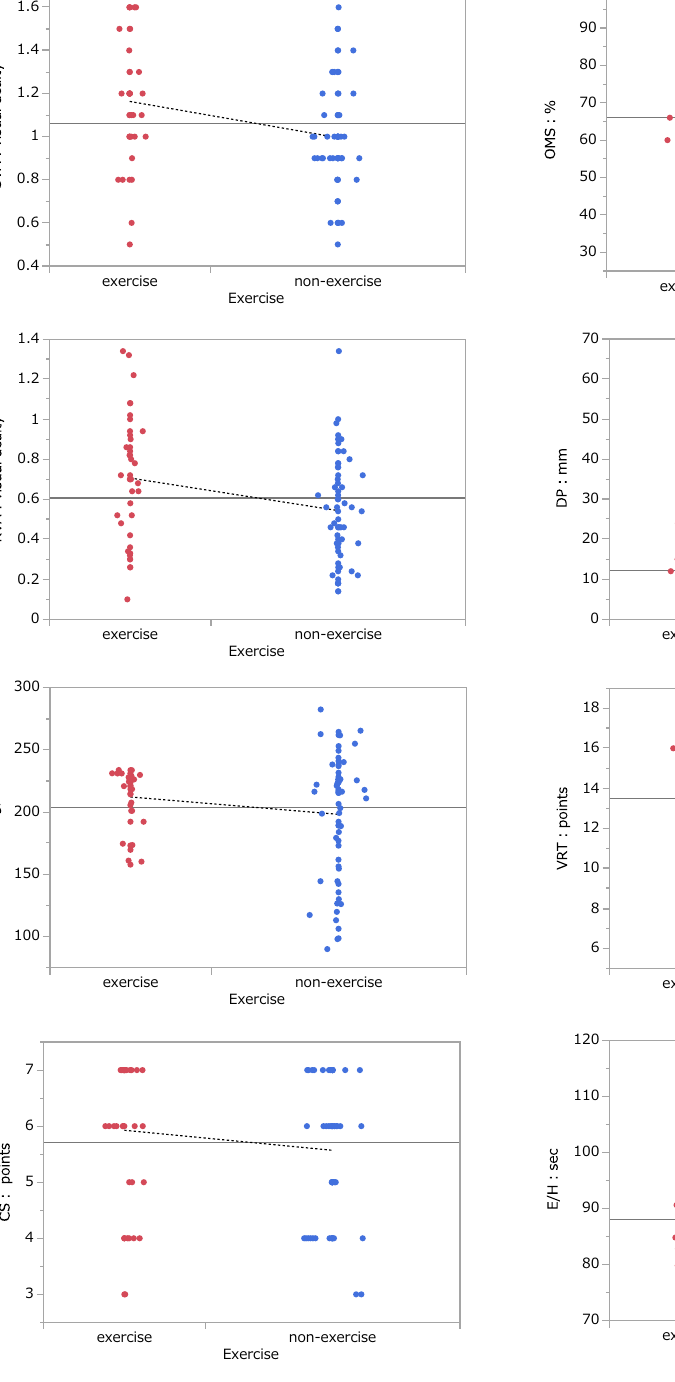
KVA, and E/H allowed rejection of the null hypothesis at the 1% level. These results suggest that SVA, KVA, and E/H are independently highly effective for distinguishing the exercise group and the non-exercise group.